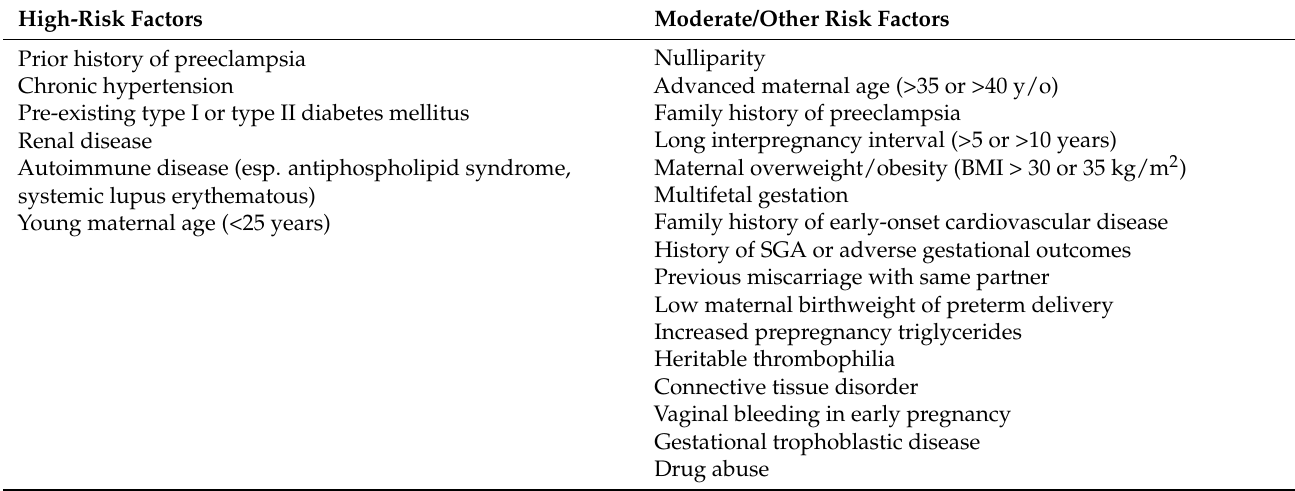
Table 3. A brief summary of risk factors for